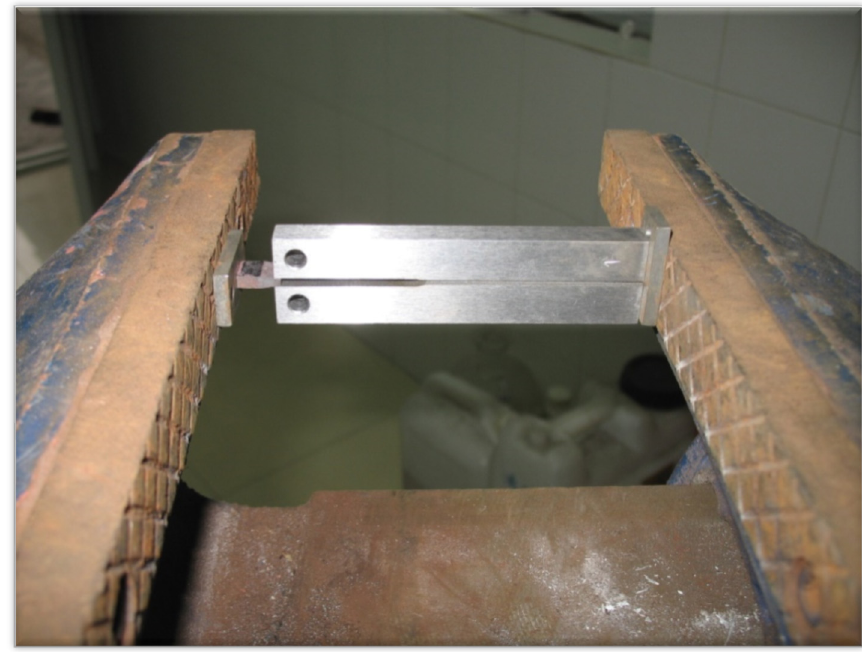
Figure 3. Experimental DCB loading device.